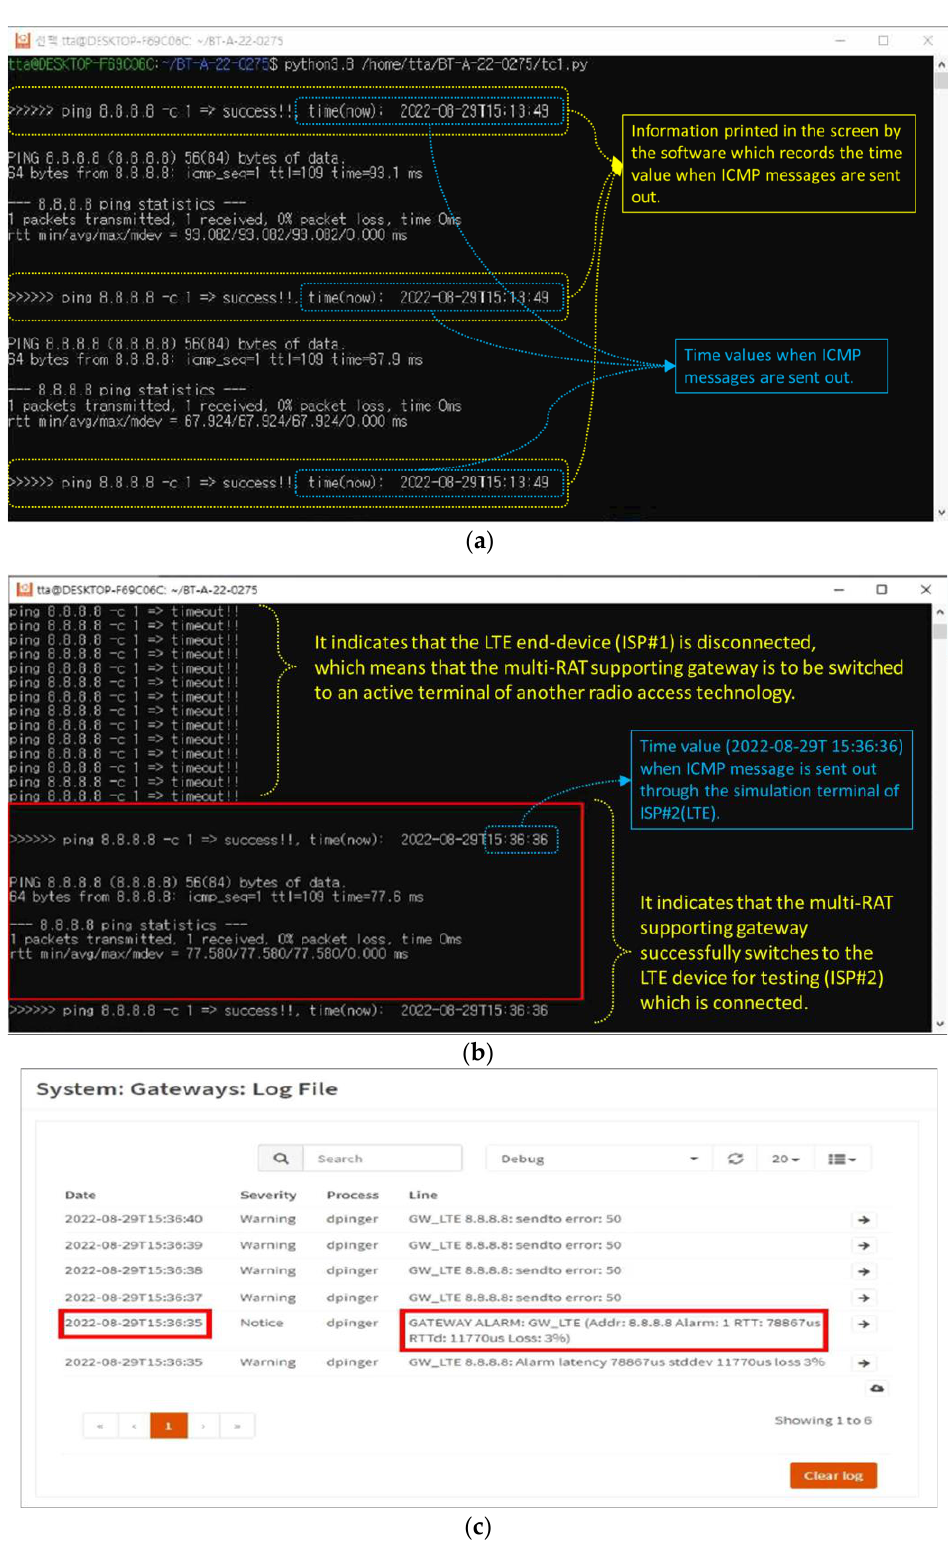
Figure 11. Experiment outcome of test scenario 1 – ( a ) Screenshot related to Step 2 of the experimental execution process; ( b ) Screenshot related to Step 4 of the experimental execution process; ( c ) Time value identified from the configuration menu of the MRGW when ‘GATEWAY ALARM occurs be- cause of the disconnection of LTE end-device (ISP#1).